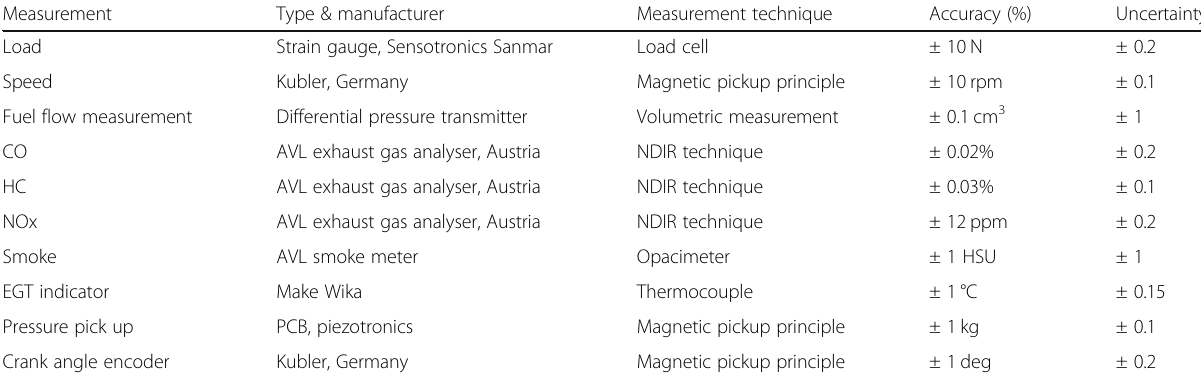
Table 4 List of instruments and their accuracy along with percentage of uncertainties [25] Measurement